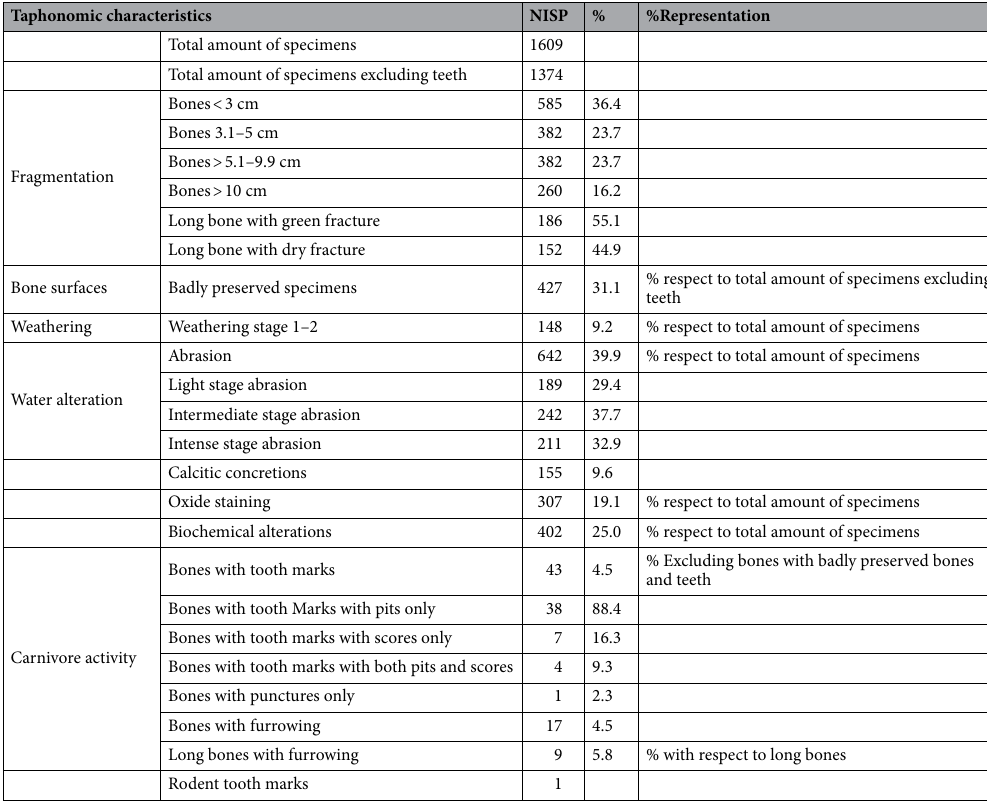
Table 2. Taphonomical characteristics of Venta Micena